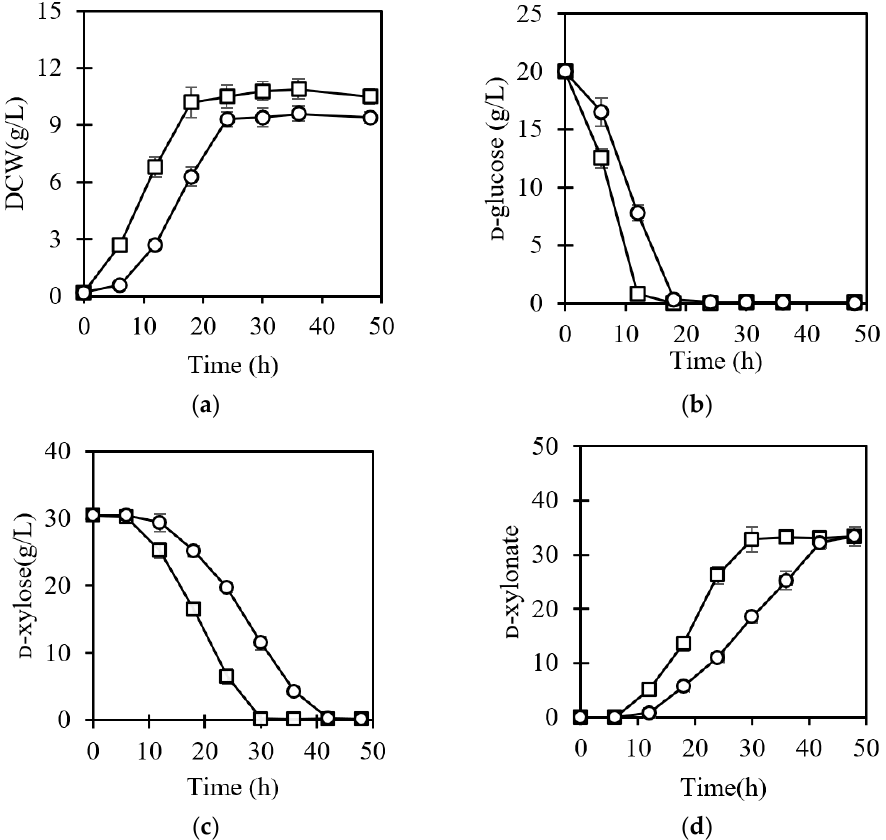
Figure 3. Effect of combined inhibitors on cell growth ( a ), ᴅ -glucose ( b ) and ᴅ -xylose consumption ( c ) and ᴅ -xylonate ( d ) production of P. kudriavzevii N-X/S1 at pH 4.0. The cells were cultured in the medium prepared by filtrated acid-pretreated corncob without detoxification (open circles) or YPD medium supplemented with 30.4 g/L ᴅ -xylose (open squares).